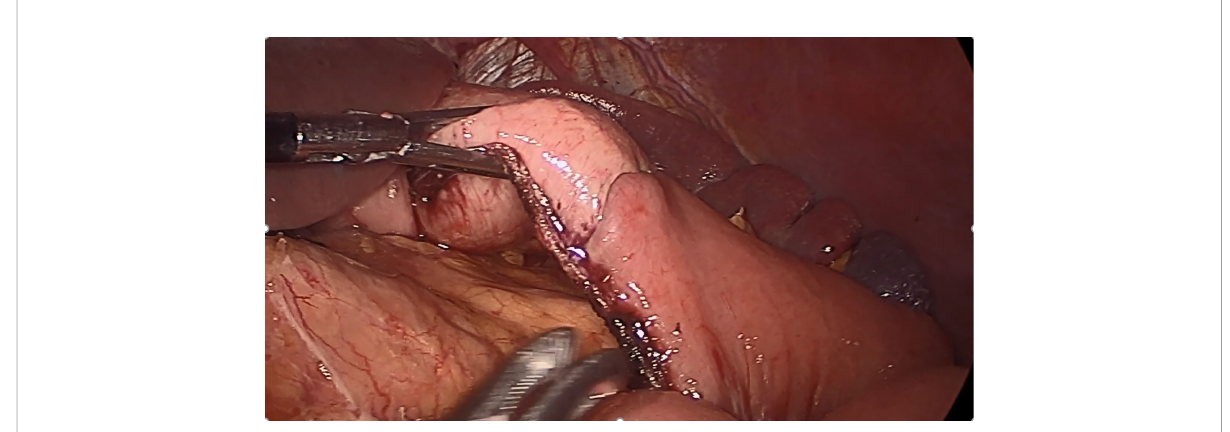
FIGURE 4 In SPLT-RY, we closed the common opening of the stomach and jejunum and cut off the stomach and jejunum in the same step, so that the stumps of the stomach and jejunum were in a completely straight line. SPLT-RY, self-pulling, and later transected